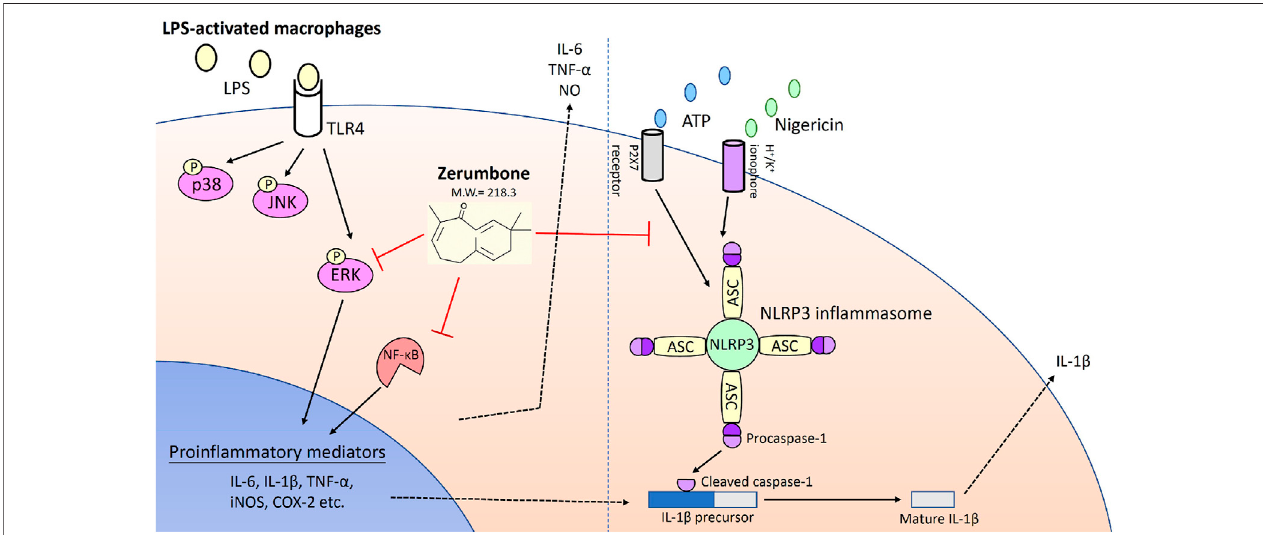
FIGURE8 | Zerumbone suppresses the LPS-inducedin fl ammatoryresponseand represses activationofthe NLRP3 in fl ammasomein macrophages. Zerumbone effectively attenuates LPS-induced in fl ammatory responses in macrophages both in vitro and ex vivo by suppressing activation of the ERK-MAPK and NF- κ B signaling pathways, inhibiting LPS-induced in fl ammatory mediators, and blocking the activation of the NLRP3 in fl ammasome.